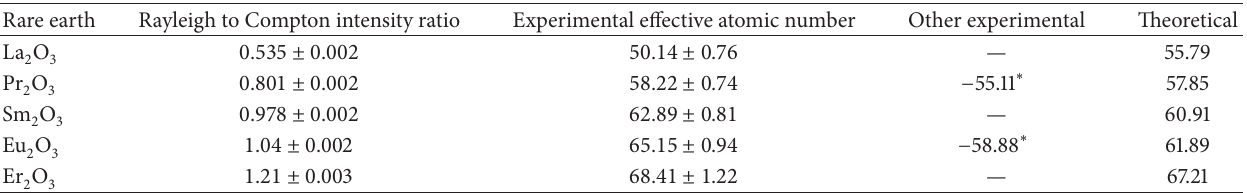
Table 1: Rayleigh to Compton scattered intensity ratio and experimental and theoretical effective atomic numbers of rare earth oxides